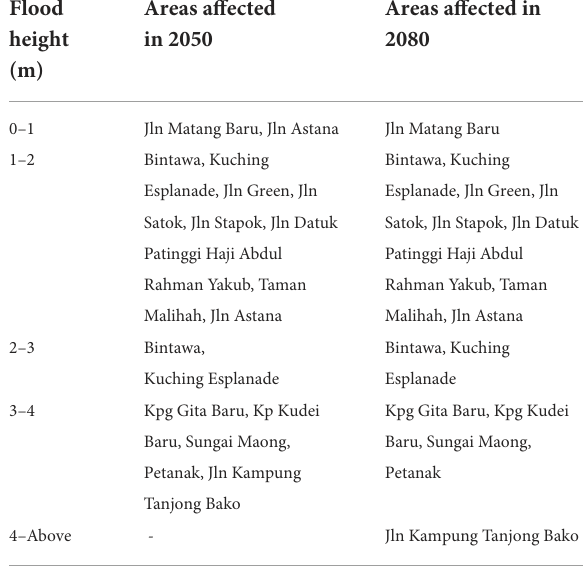
TABLE 1 Flood height and affected